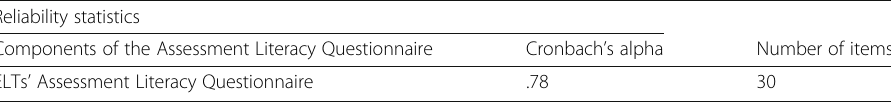
Table 2 Cronbach ’ s alpha of the ELTs ’ Assessment Literacy Questionnaire